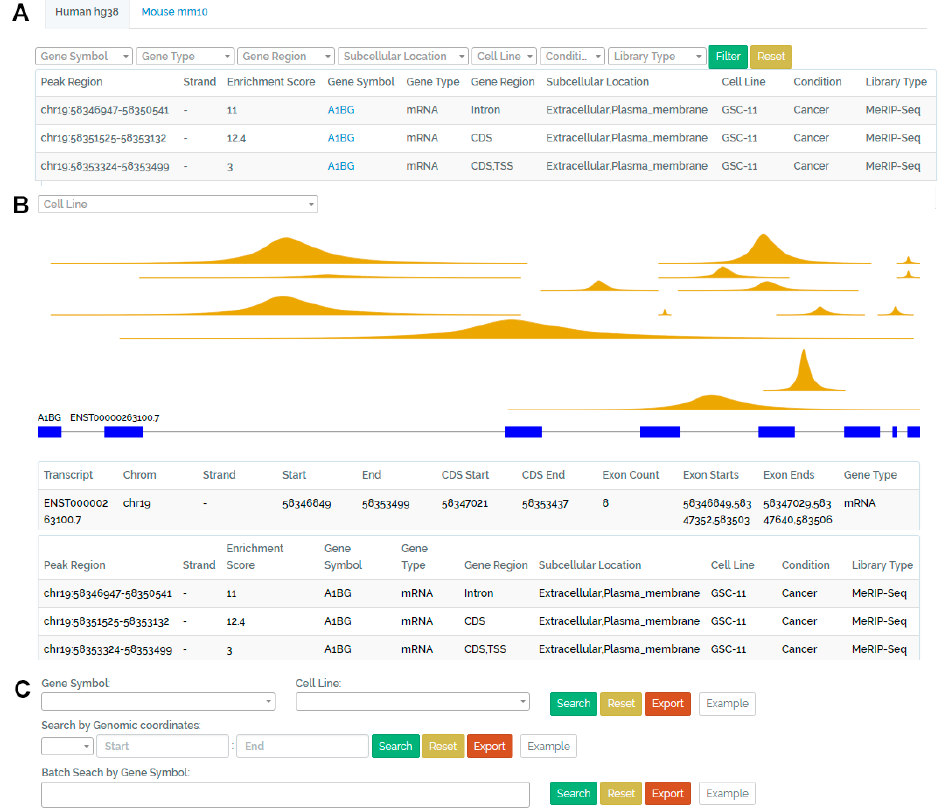
Figure 2. Overview of CVm6A. ( A ) Browse page. All m 6 A peaks in this page can be filtered by gene symbol, gene type, gene region, subcellular location, cell line, condition and library type. The peak region and gene symbol are linked to the visualization page. ( B ) Visualization page. All m 6 A peaks in a selected gene are displayed with dark yellow color. Peaks in selected cell lines are displayed with brown color. Annotated gene and transcripts structure are displayed in blue box (exon) and gray line (intron). Coordinates of annotated transcripts and table with detailed information corresponding to these peaks are displayed below. ( C ) Search page. Users can search all m 6 A peaks in a special gene or cell line. The Search function by genomic coordinates supports fuzzy search of all peaks surrounding the input genomic region. Batch search by gene symbol is also